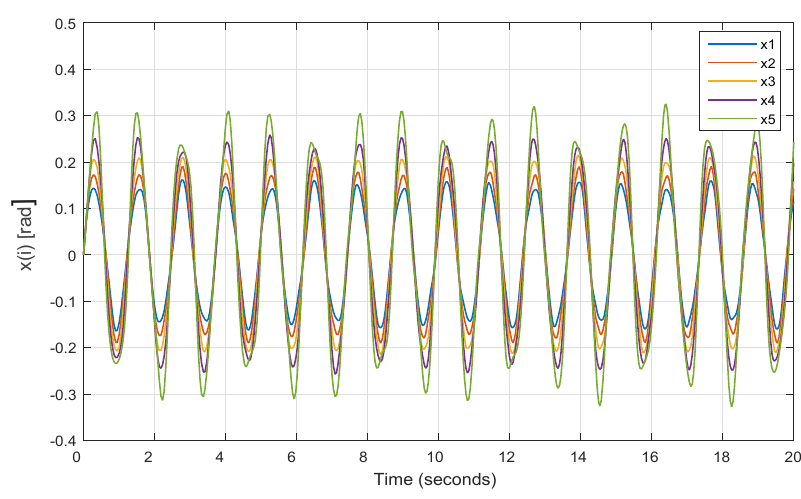
Figure 4. The angular position of flexible bar without